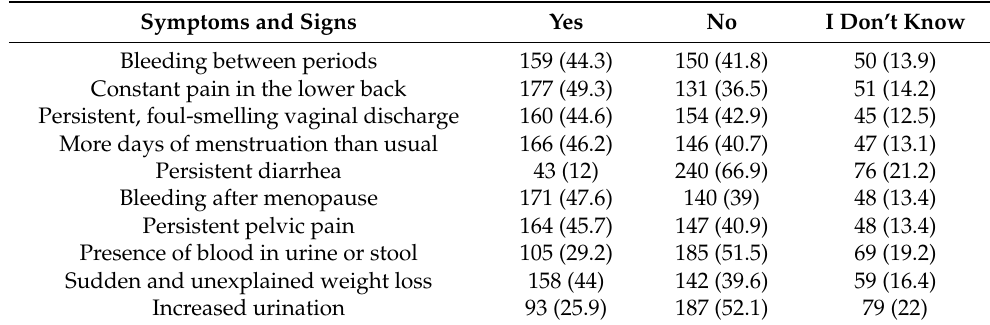
Table 2. Knowledge and belief of participants about symptoms and signs of cervical cancer.